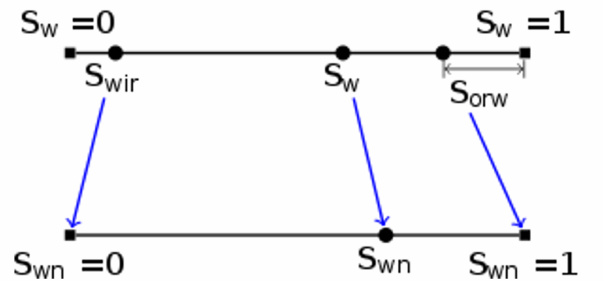
Figure 7. Equivalence between the real saturation profile ( top ) and the effective normalized saturation profile ( bottom